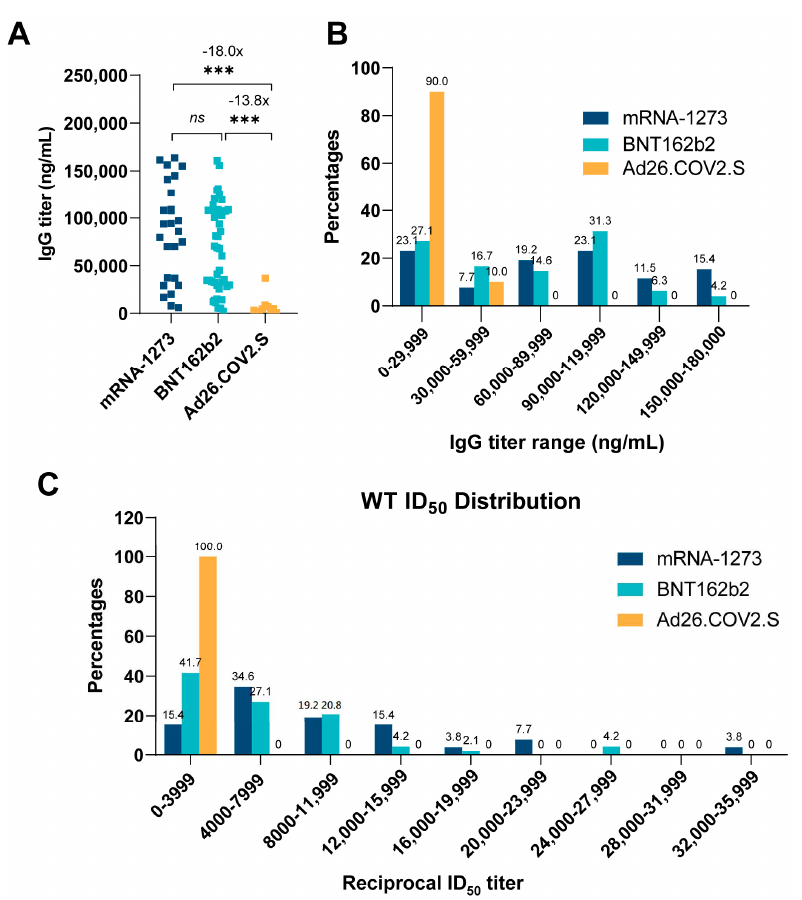
Figure 1. Distribution of specific anti-SARS-CoV-2 S1 IgG in plasma from vaccine recipients and distribution of ID 50 values for SARS-CoV-2 WT. IgG titers and relative frequency for three vaccine groups ( n = 10 for Ad26COV2.S, n = 26 for mRNA-1273 and n = 48 for BNT162b2). ( A ) Plasma anti-spike IgG titer comparison. Individual IgG titers in plasma collected from the vaccines are determined by ELISA assay and plotted for each vaccine group. A Kruskal–Wallis one-way ANOVA with Dunn’s Multiple comparisons test (comparing each column to every other column) was used to evaluate for statistical significance, which is defined as follows: *** ( p ≤ 0.001). The numbers above asterisk indicate fold changes of IgG titers between two groups (the pairwise comparisons). ( B ) IgG titer frequency. Anti-spike IgG titers are depicted in 30,000 ng/mL intervals. The numbers on the top of each bar are the percentage of subjects whose IgG titers fall within the range shown on the abscissa axis. ( C ) Neutralizing ID 50 values distribution of each vaccine group against SARS-CoV-2 WT. The numbers on the top of each bar are the percentage of subjects whose neutralizing ID 50 titers fall within the range shown on the abscissa axis. GraphPad Prism version 9.1.1 was used for all statistical analysis for this figure.